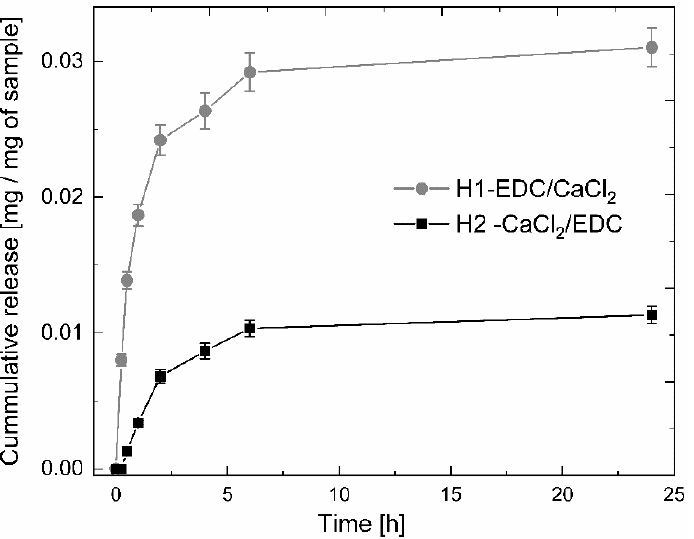
Figure 6. Release profiles obtained for the hydrogels H1-EDC/CaCl 2 and H2-CaCl 2 /EDC.